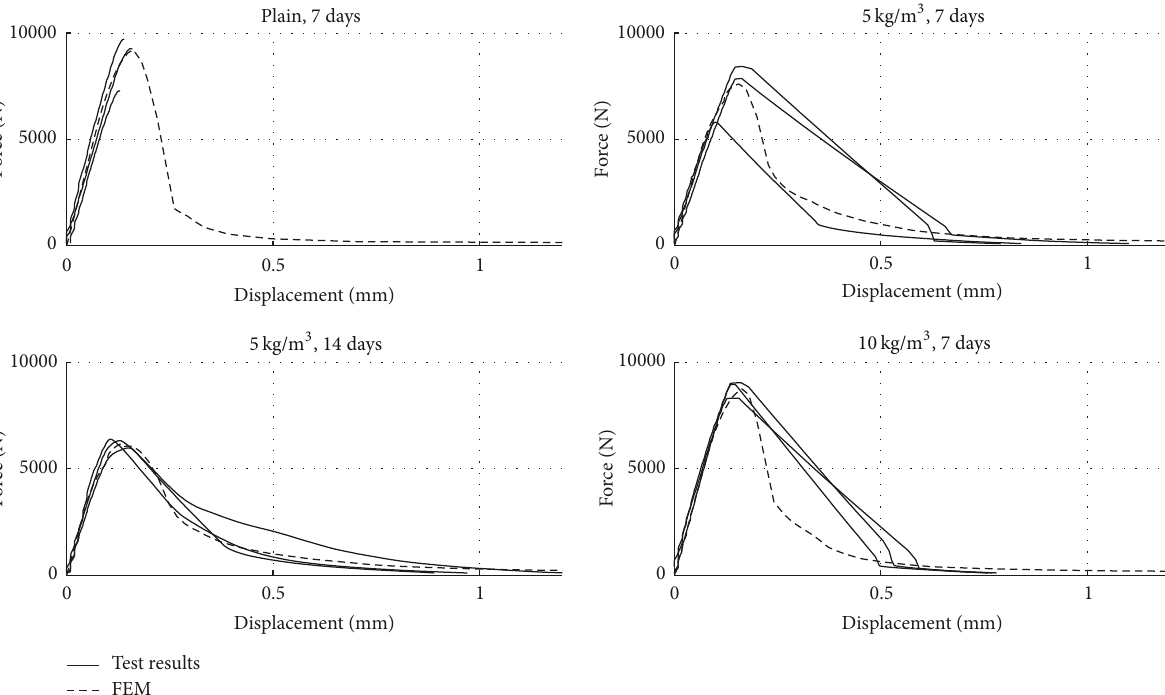
Figure 2: Force-displacement curves from experimental tests [15] and numerical